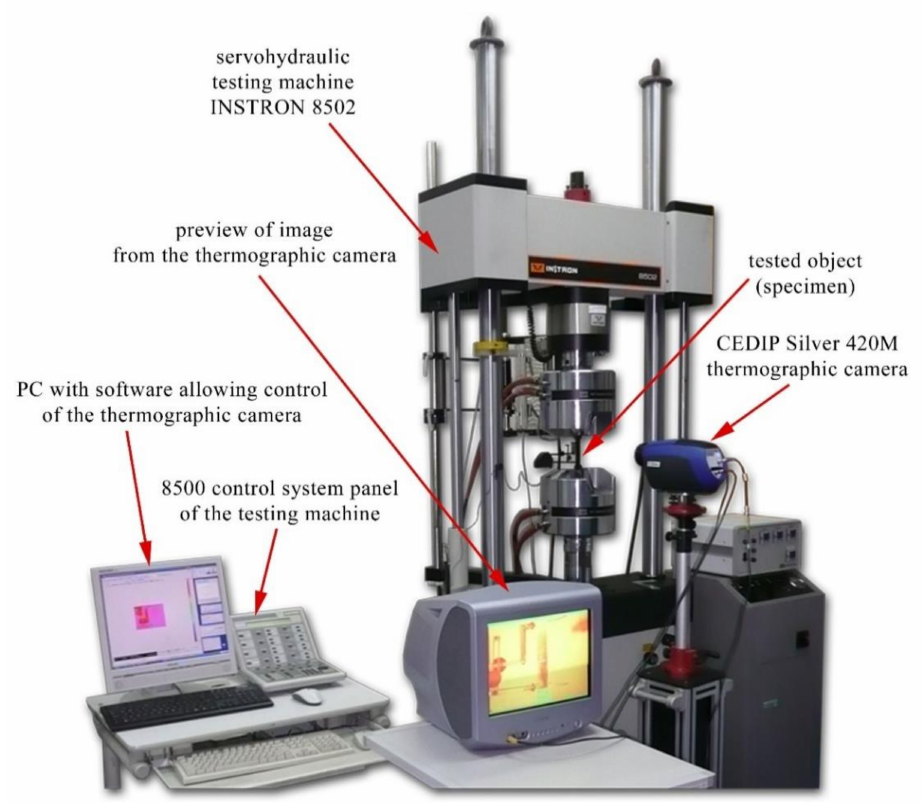
Figure 2. Test station with the thermographic measurement